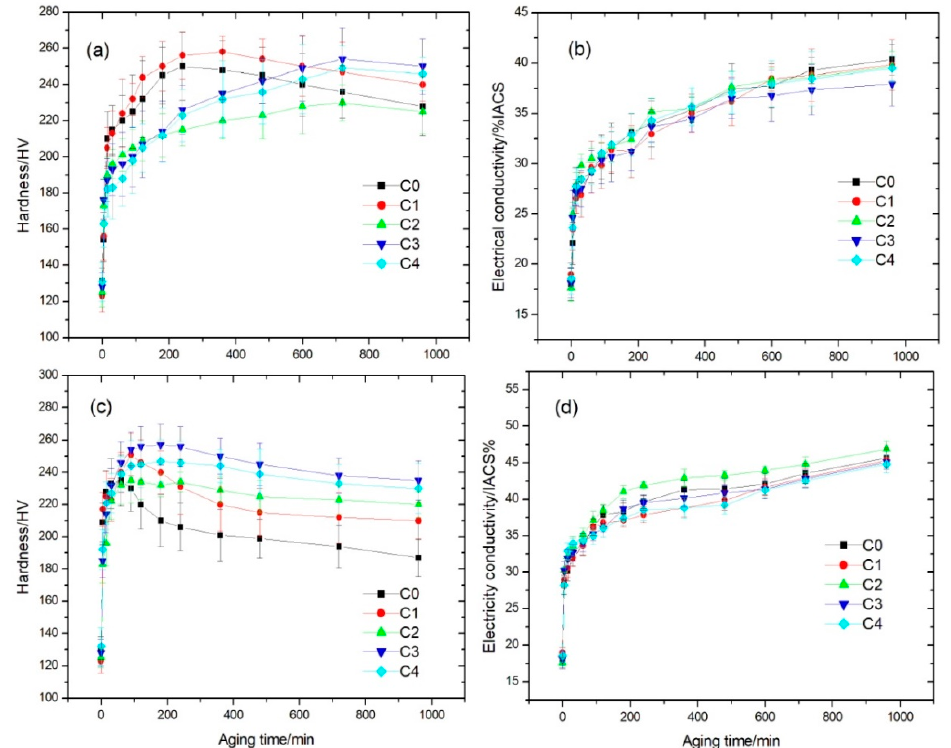
Figure 1. Hardness and electrical conductivity curve of as-quenched Cu-Ni-Co-Si-P-Mg alloys as a function of aging time at different aging temperature ( a ) hardness, aging at 450 °C, ( b ) electrical conductivity, aging at 450 °C, ( c ) hardness, aging at 500 °C, ( d ) electrical conductivity, aging at 500 °C.